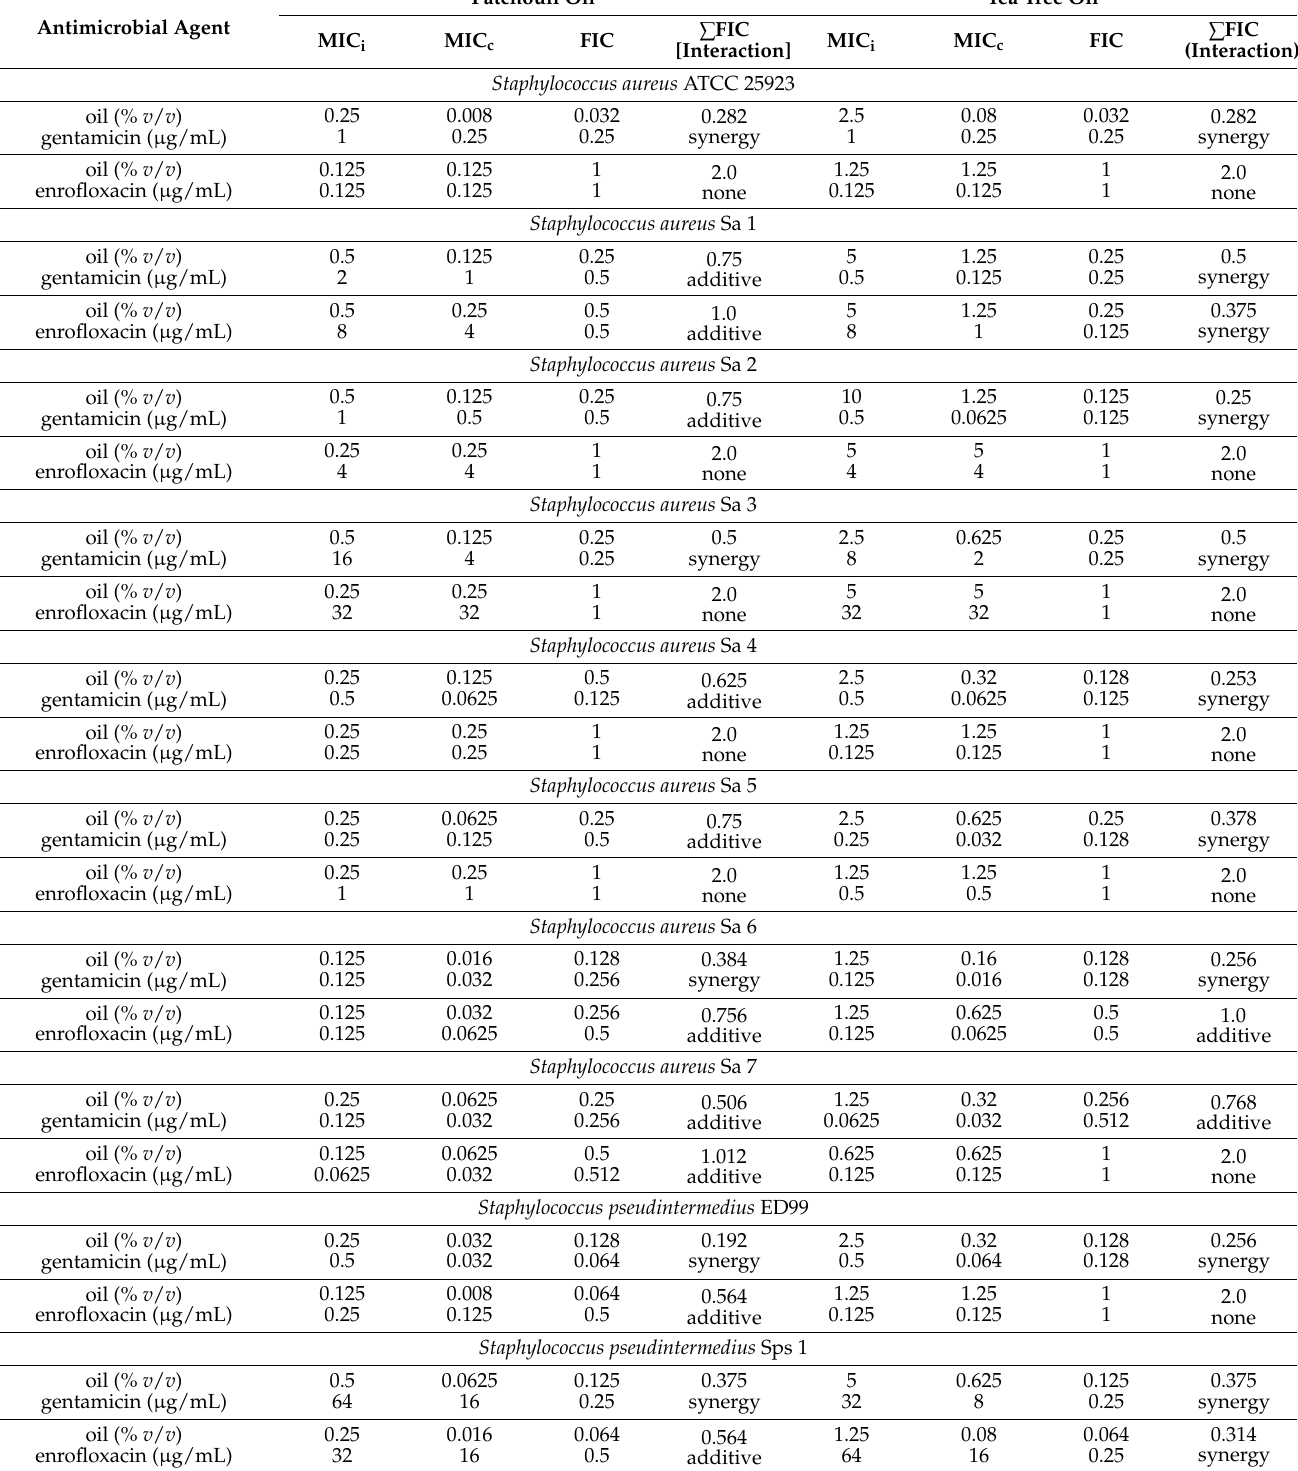
Table 3. Checkerboard analysis with final interactions (best match within